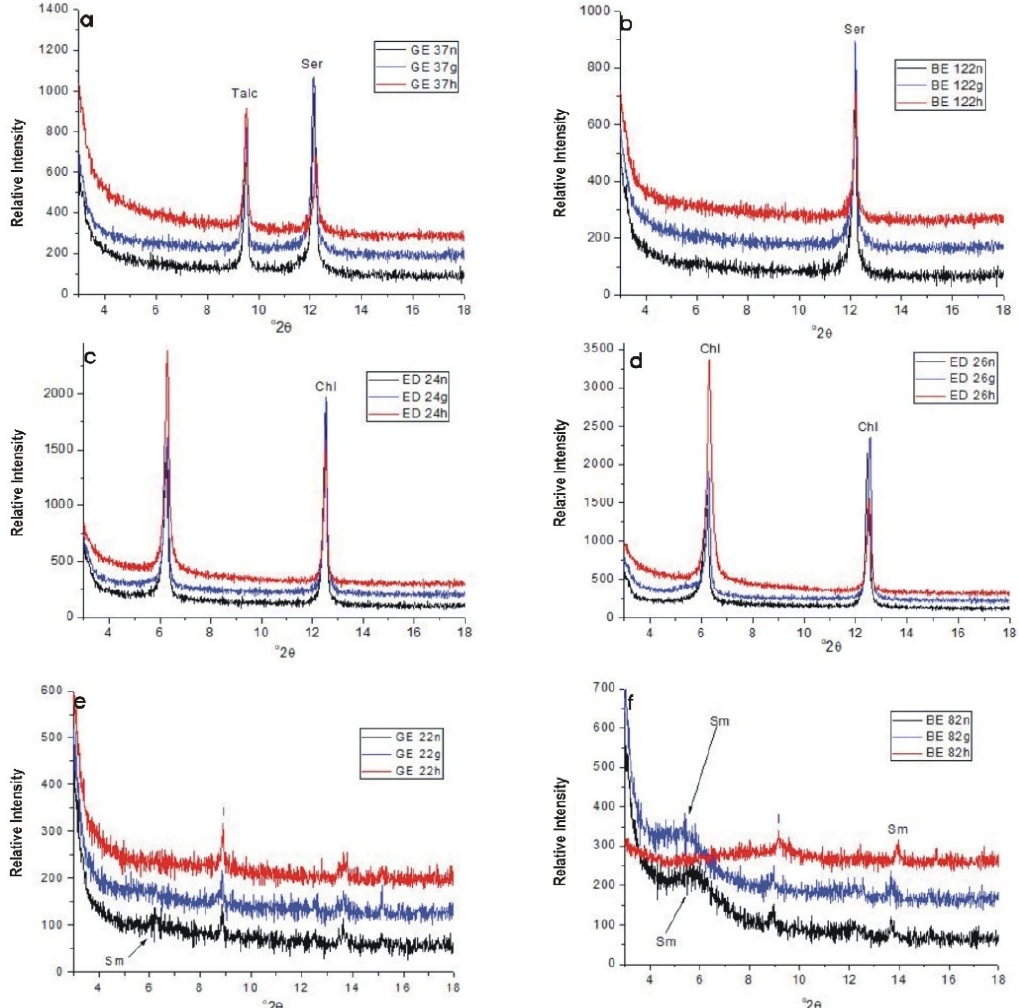
Figure 3. X-ray diffraction patterns of the clay fraction of representative studied samples: ( a ) Dunite (sample GE.37); ( b ) Serpentinized harzburgite (sample BE.122); ( c ) Diabase (sample ED.24); ( d